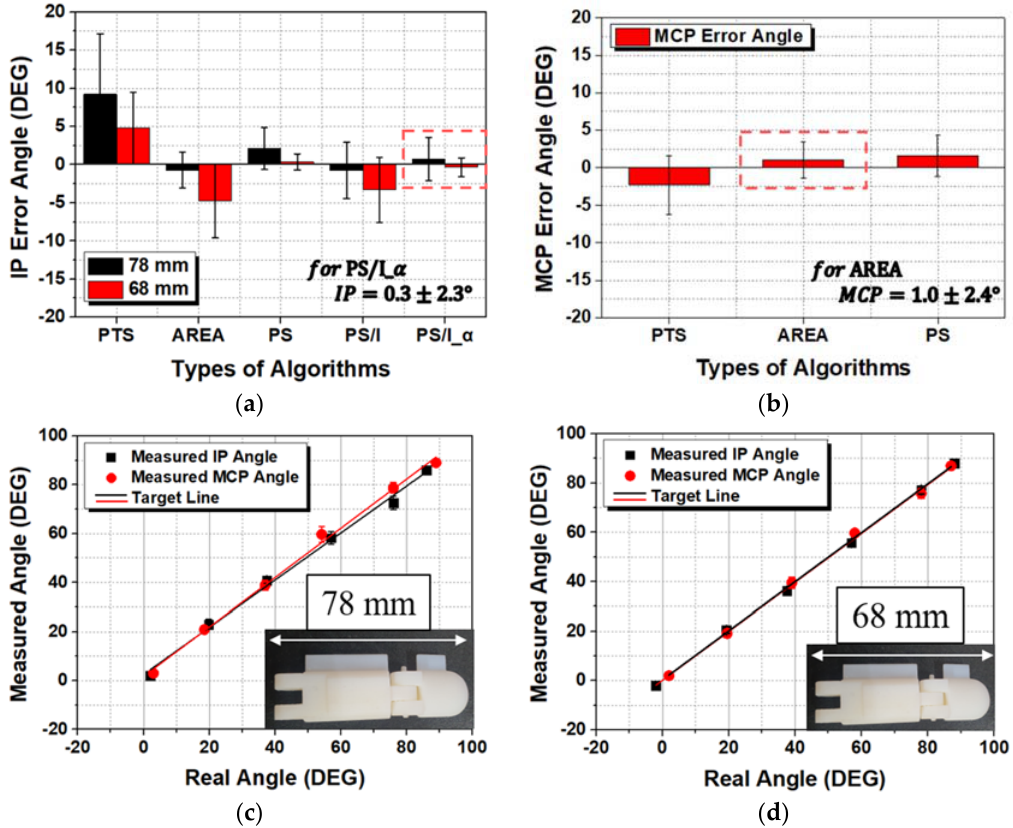
Figure 11. Measured angles versus real angles (measured by a goniometer) with respect to the size of the thumb: Angle errors of the ( a ) interphalangeal (IP) joint and ( b ) MCP joint; linearity at ( c ) 78 and ( d ) 68 mm according to the algorithm and type of joint.